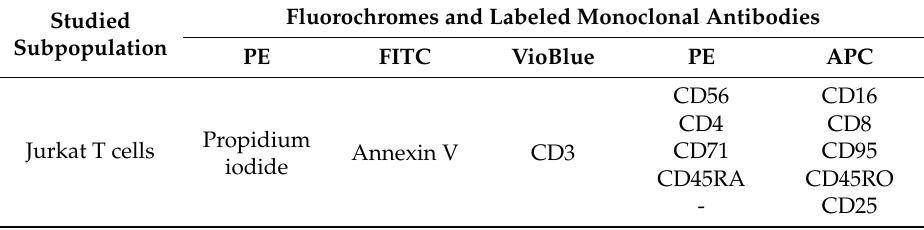
Table 2. Monoclonal antibody panel used for Jurkat T cell analysis. Studied